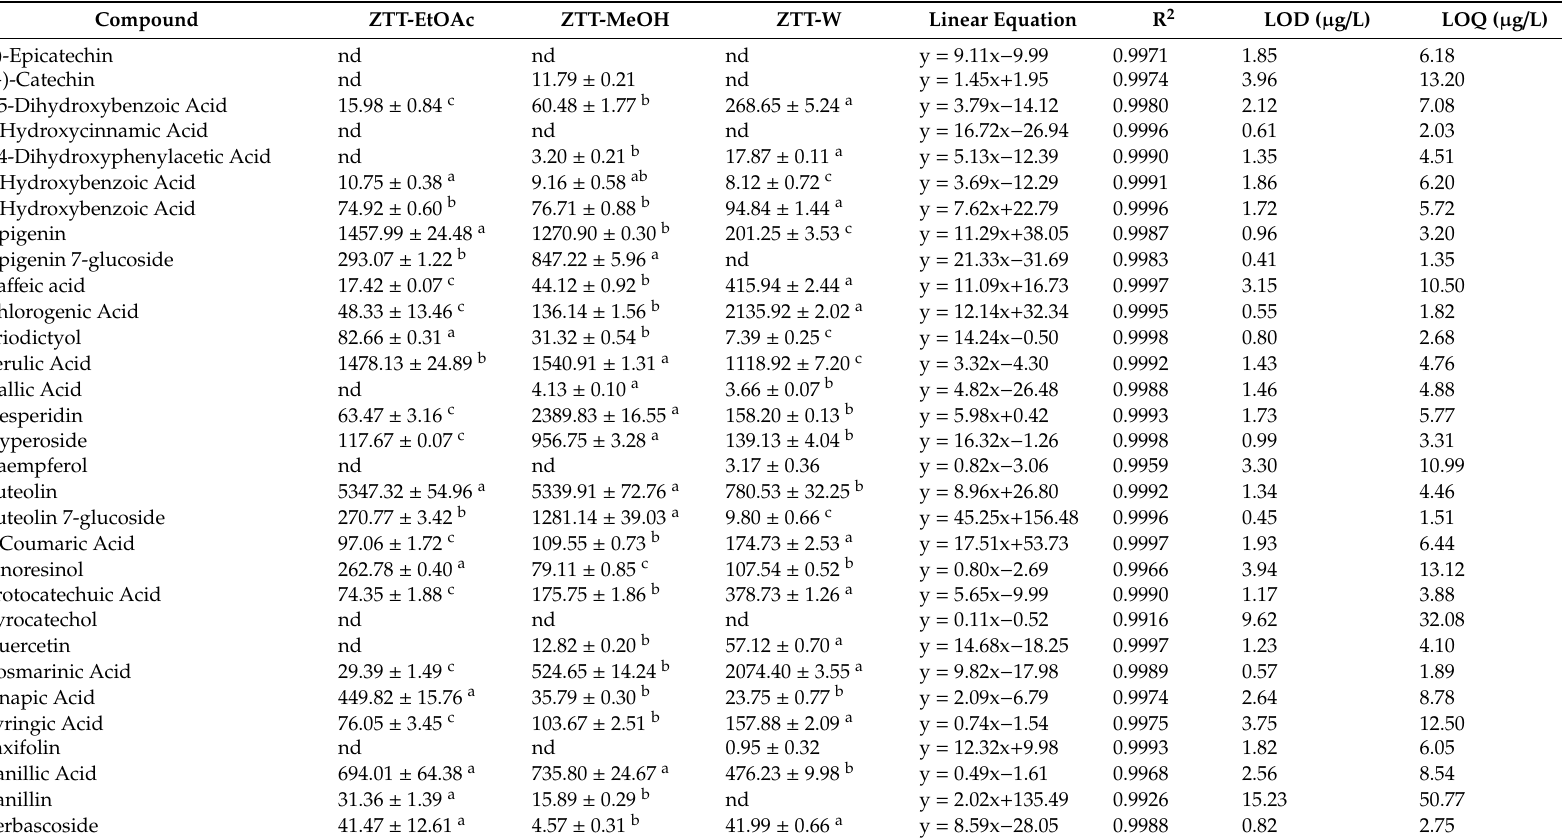
Table 2. Concentration ( µ g / g extract) and analytical characteristics of selected phytochemicals in the solvent extracts from Z. taurica subsp. taurica x